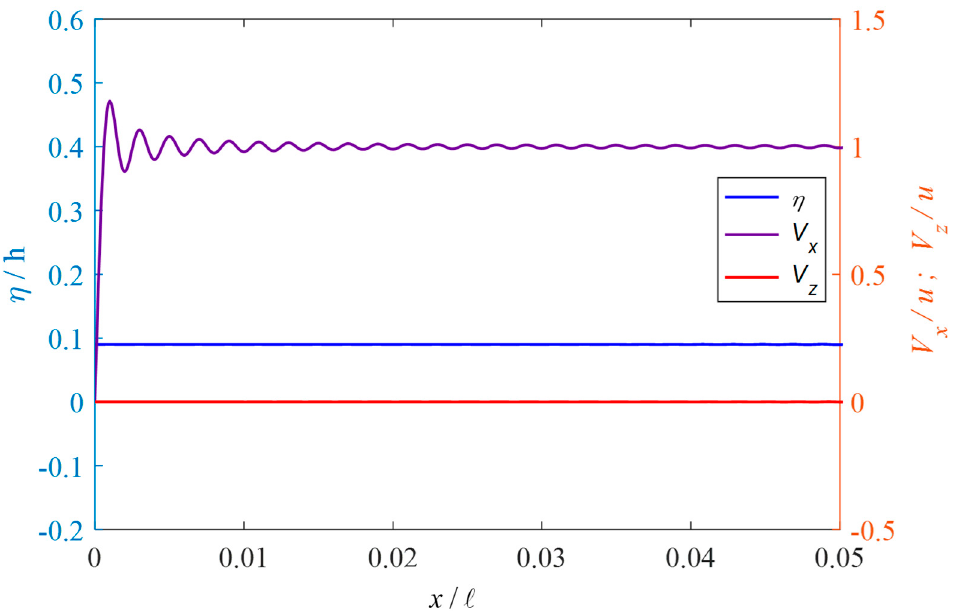
Figure 6. Closer look of horizontal velocity near x =